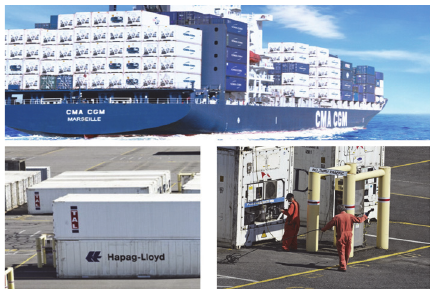
Figure 1: Fleet, reefers, and mechanics (http://www.cma-cgm.com &